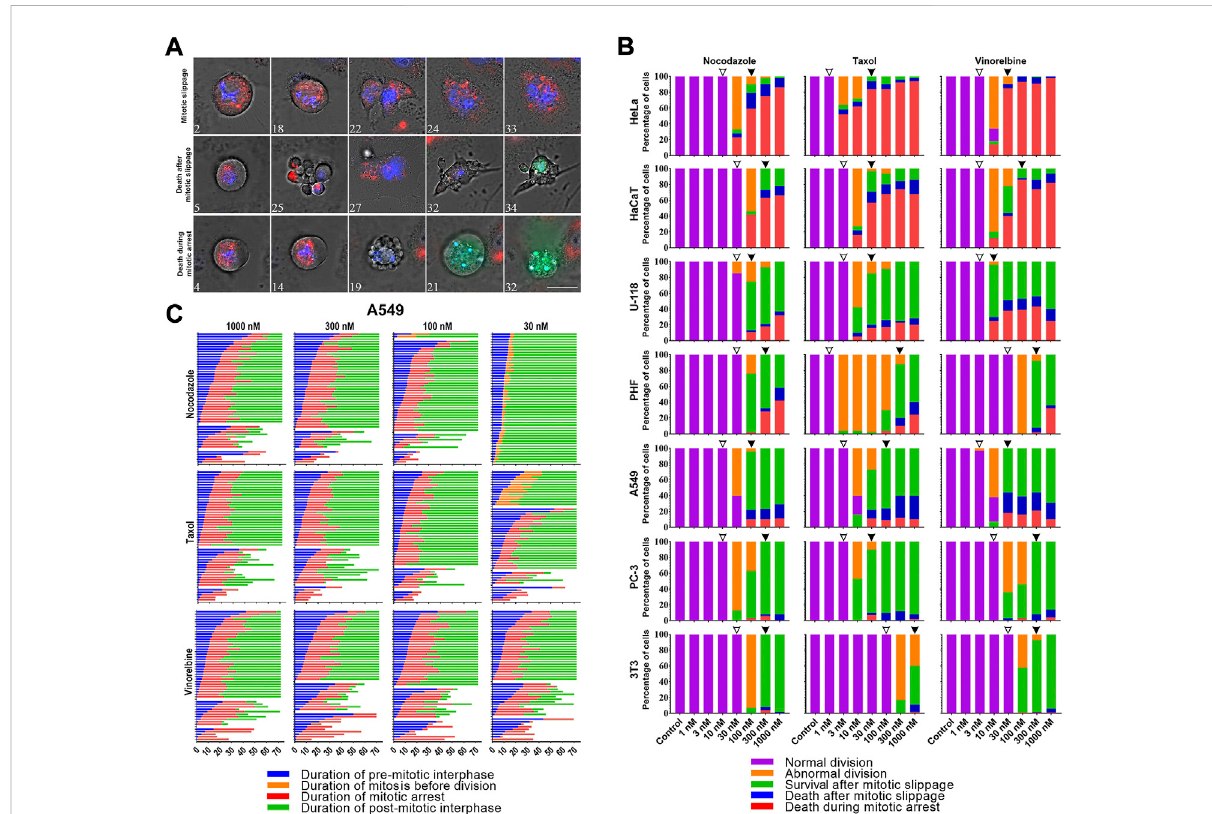
FIGURE 2 (A) Time-lapse sequences illustrating three fates (mitotic slippage, death after mitotic slippage, and death in mitosis) exhibited by A549 cells under the treatment with 1 uM Taxol. Numbers indicate time from the moment of mitotic entry in hours. Mitochondrial membrane potential was visualized after staining with 50 nM TMRE (red), active caspases 3/7 with caspases 3/7 detecting reagent (green), and nuclei with 200 nM Hoechst 33342(blue). The images were acquired using a Planapo ×63 oil immersion objective with NA = 1.46. Scale bar = 20 µm. (B) Threshold- dependentresponseofHeLa,HaCaT,U-118,PHF,A549,PC-3,and3T3celllinesafter72 hoftreatmentwith1 – 1000 nMdosesofnocodazole,Taxol, andvinorelbine.Fromtoptobottomcelllinesareplacedinorderofdecreasingsensitivitytodeathinmitosis.Thresholddosesareindicatedbyempty (T1) and fi lled (T2) arrowheads. (C) Life histories of individual A549 cells treated with 30 – 1000 nM doses of nocodazole, Taxol, or vinorelbine. Each horizontal line represents a single cell. Numbers along the x-axis indicate the time from the moment addition of the drug in